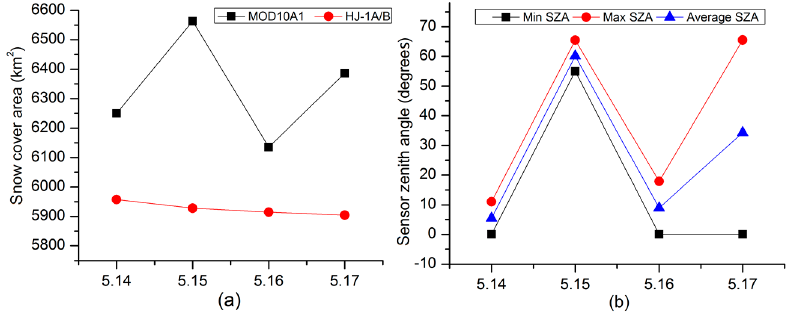
Figure 3. Changes in: ( a ) snow cover area calculated from MOD10A1 and HJ-1A/B data; and ( b ) the sensor zenith angle (SZA) value in a typical area of the Tarim River Basin on 14–17 May 2011.